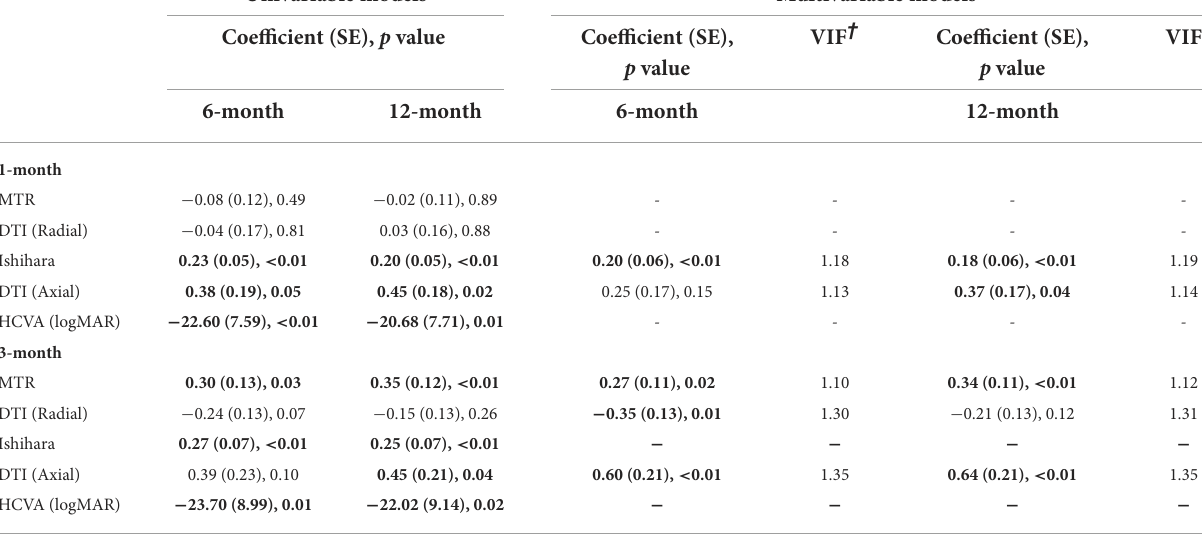
*Retinalnervefibrelayer. †